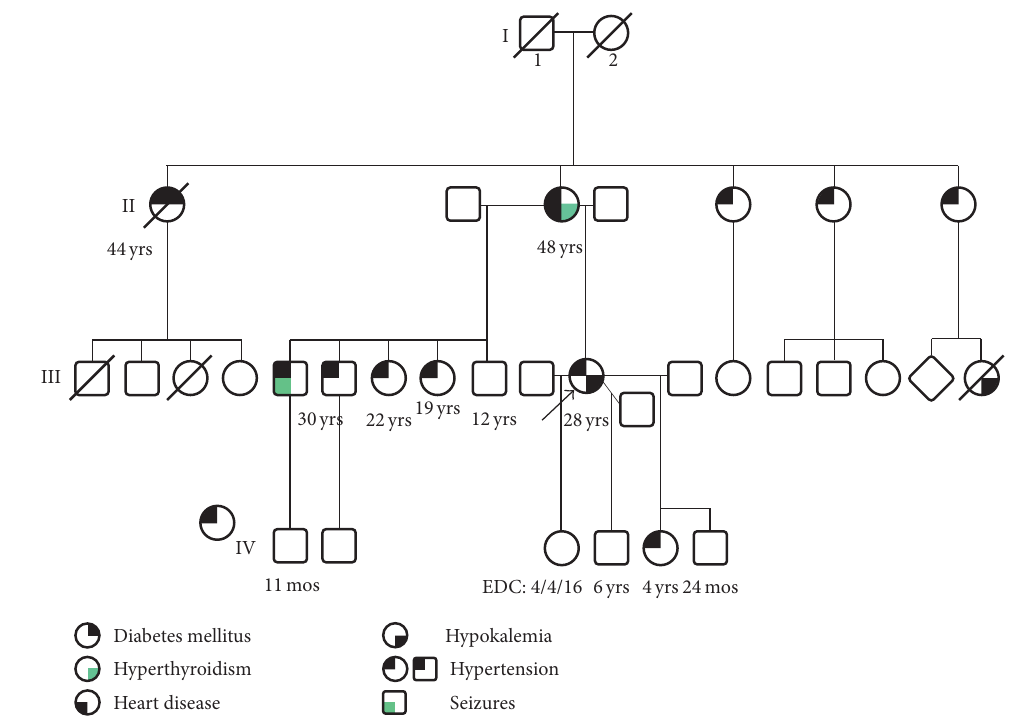
Figure 1: Patient’s family